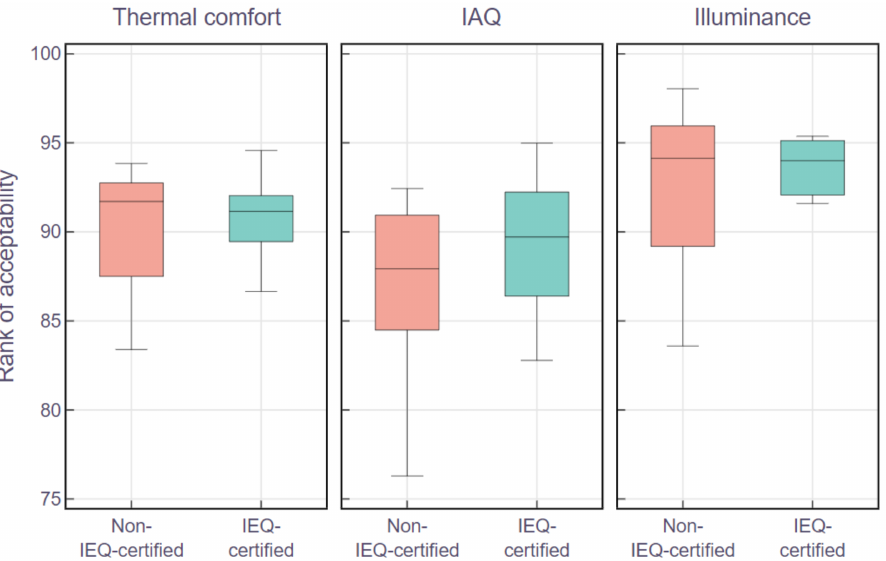
Figure 4. Acceptance of IEQ components. Orange represents non-IEQ-certified, green represents